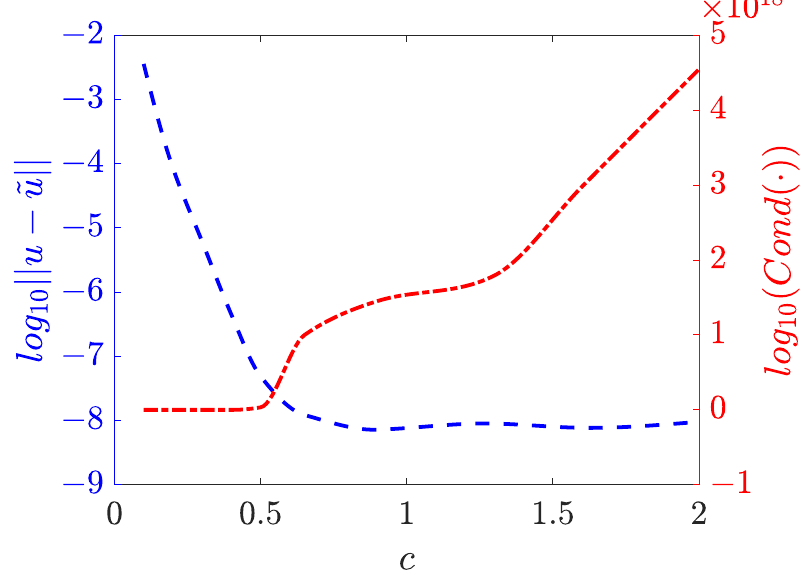
Figure 1. Variation of accuracy and condition number of the stiffness matrix with shape parameter c when N s =